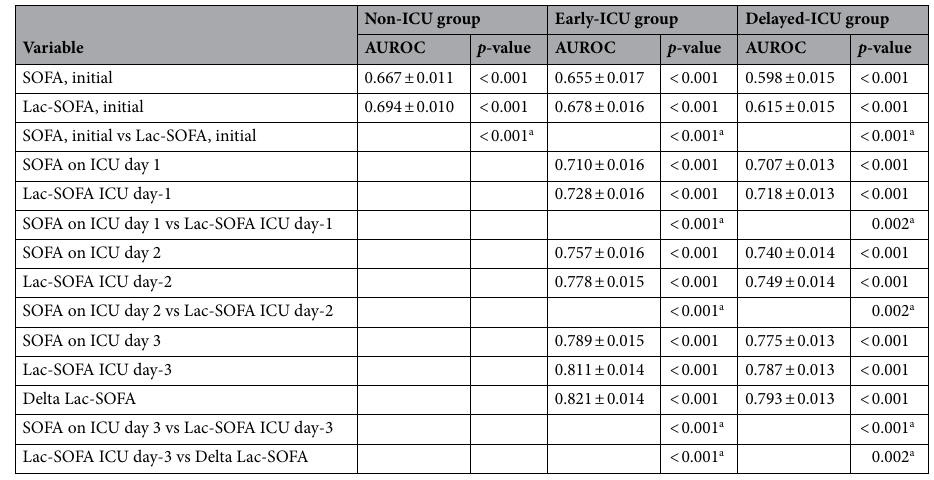
Table 3. AUROCs for in-hospital mortality based on the SOFA, Lac-SOFA, and Delta Lac-SOFA scores. ROC receiver operating characteristic, AUROC area under the ROC curve, ICU intensive care unit, SOFA Sequential Organ Failure Assessment score, Lac‑SOFA score sum of SOFA score and Lac-score, Delta Lac‑SOFA score sum of Lac-SOFA ICU day-3 score and Delta Lac-score. a Two-tailed DeLong’s test for two correlated ROC curves.